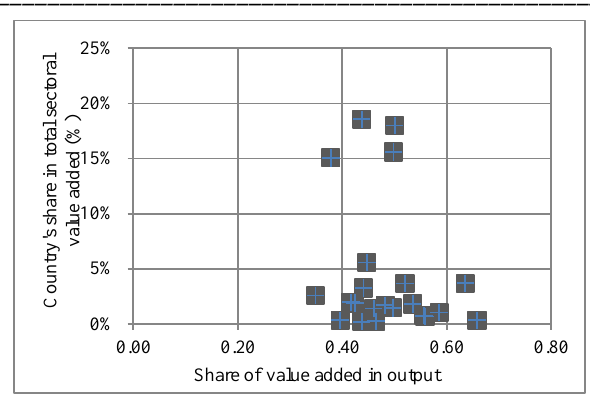
Fig. 4. Telecommunications in the EU in 2010.